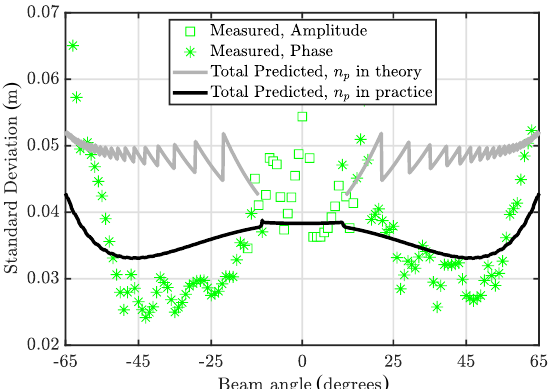
Figure 4. Predictions of total bathymetric uncertainty for a water depth of 30m and a pulse length of 134µs using the number of phase samples obtained from Equation (5) (gray) and extracted from the data (black). Shown with green markers are the measured vertical uncertainties. The transition from the amplitude to phase detection is shown by changing the square marker to an